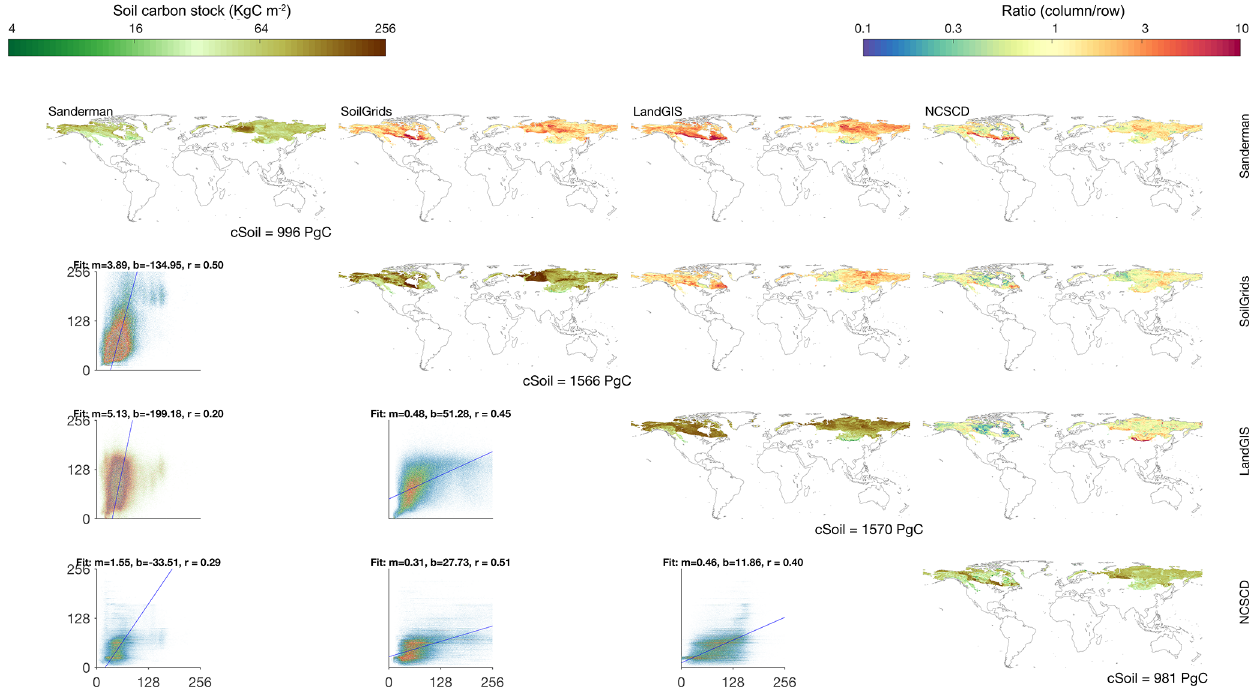
Figure 2. The same as Fig. 1 except for the C soil in 0–200cm soil depth and in the circumpolar regions.